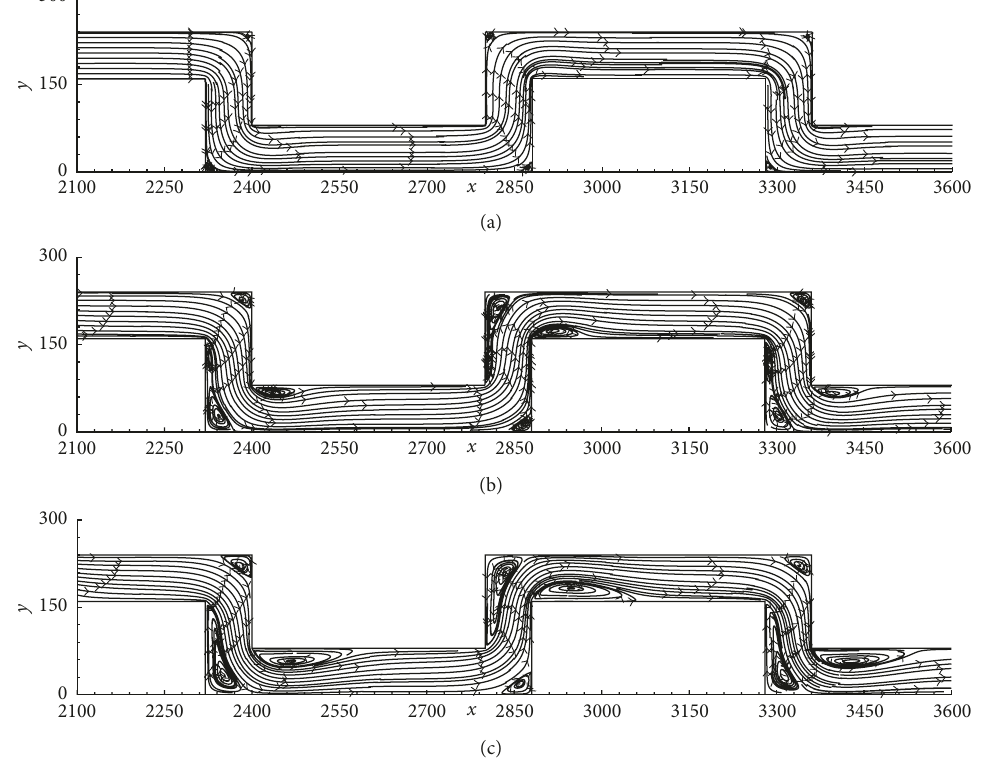
Figure 3: Streamlines of steady flow field at (a) Re